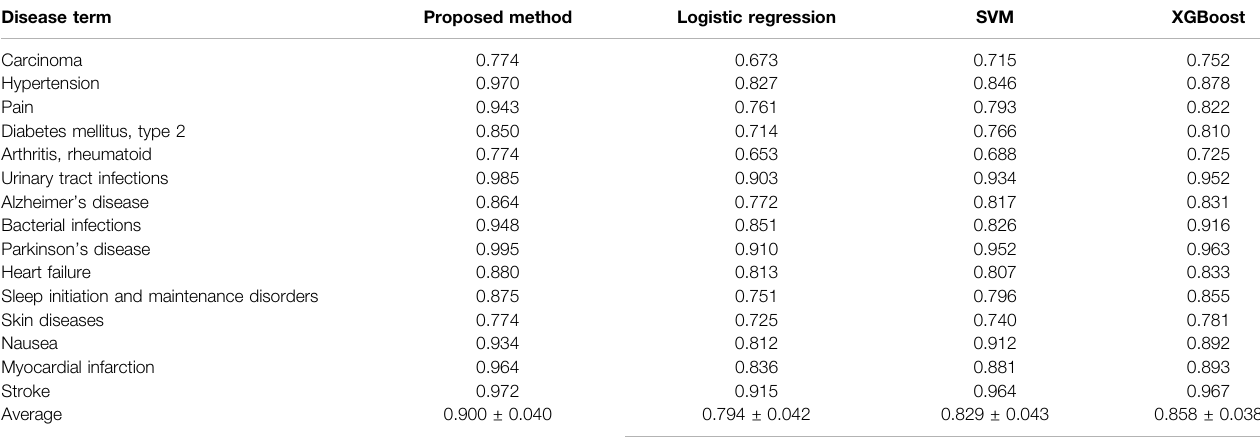
TABLE 2 | Comparison of AUROC values of the proposed method with three machine learning-based methods, including logistic regression, SVM, and XGBoost. Disease term